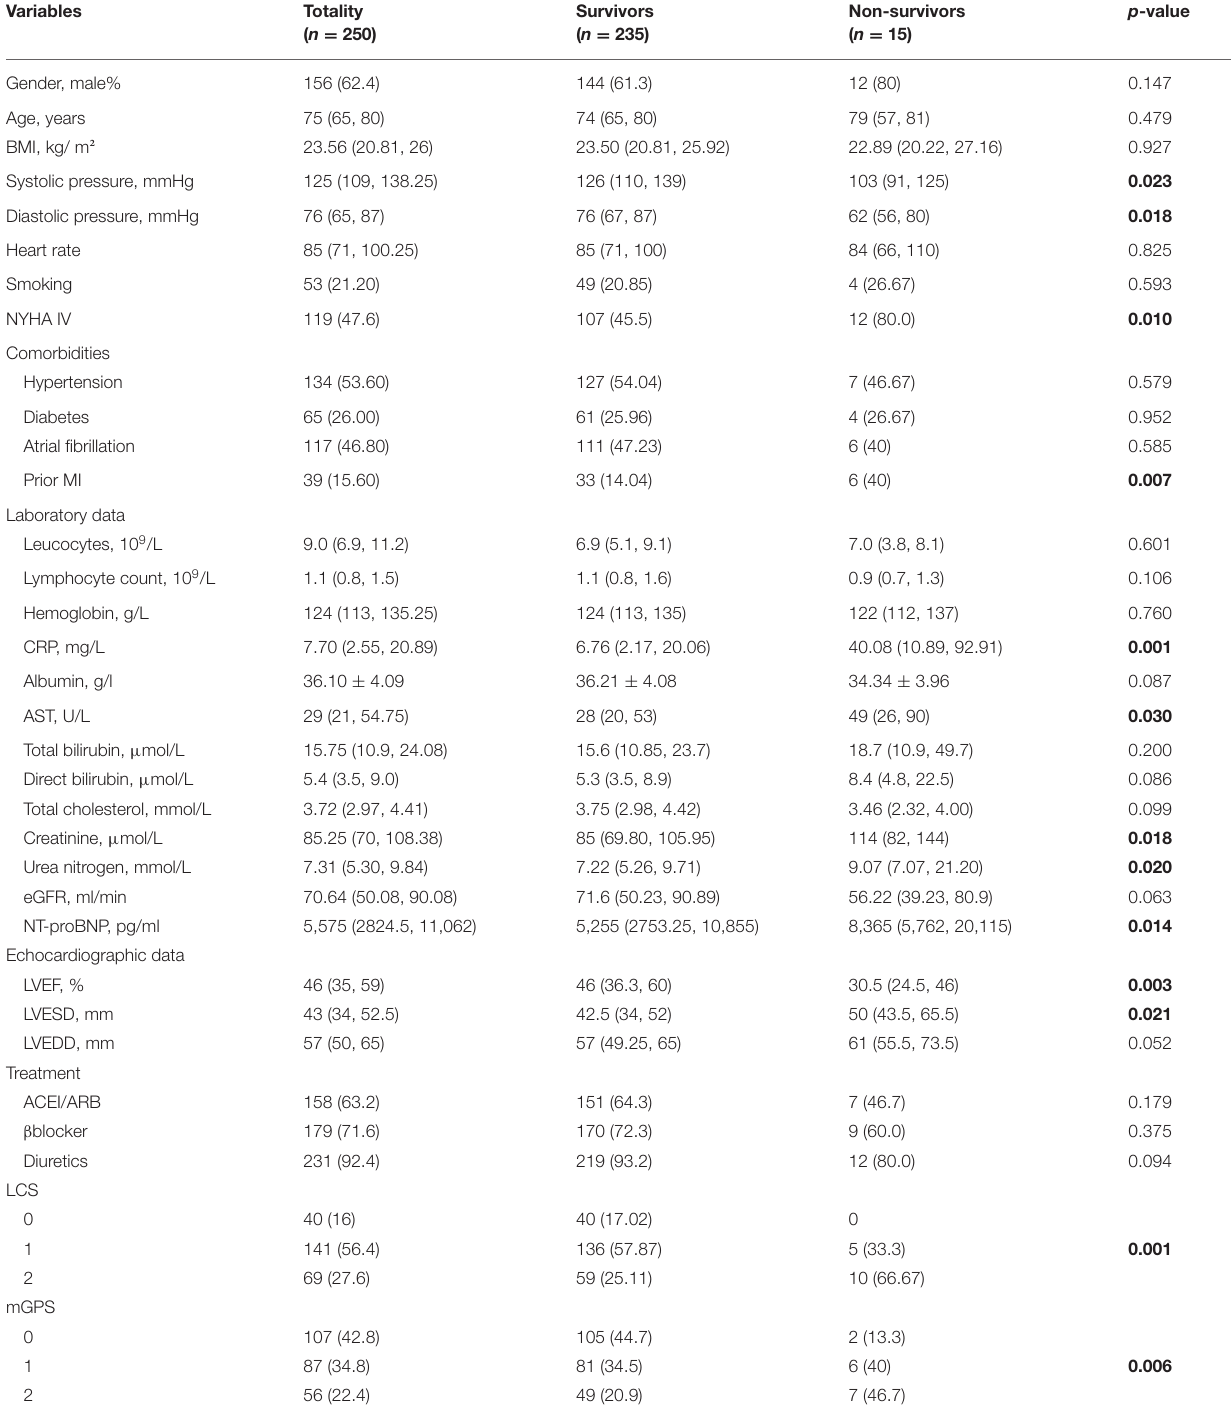
TABLE 2 | Characteristics of patients who reached and did not reach the primary outcome.